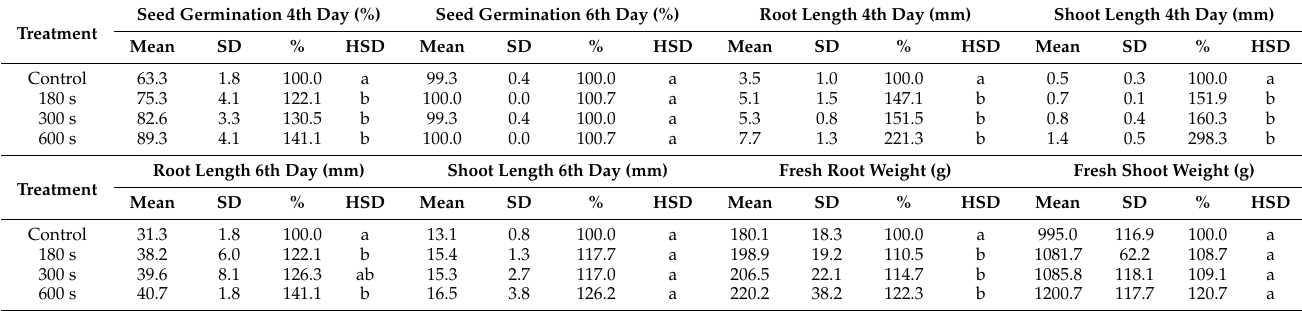
Table 1. Basic characteristics of seed germination and seedling early growth in maize after Gliding Arc plasma treatment. Mean, standard deviation (SD), percentage relative to control (%), and results of Tukey HSD test for multiple comparisons (HSD) are presented. HSD—different letters indicate a significant statistical difference p < 0.05.